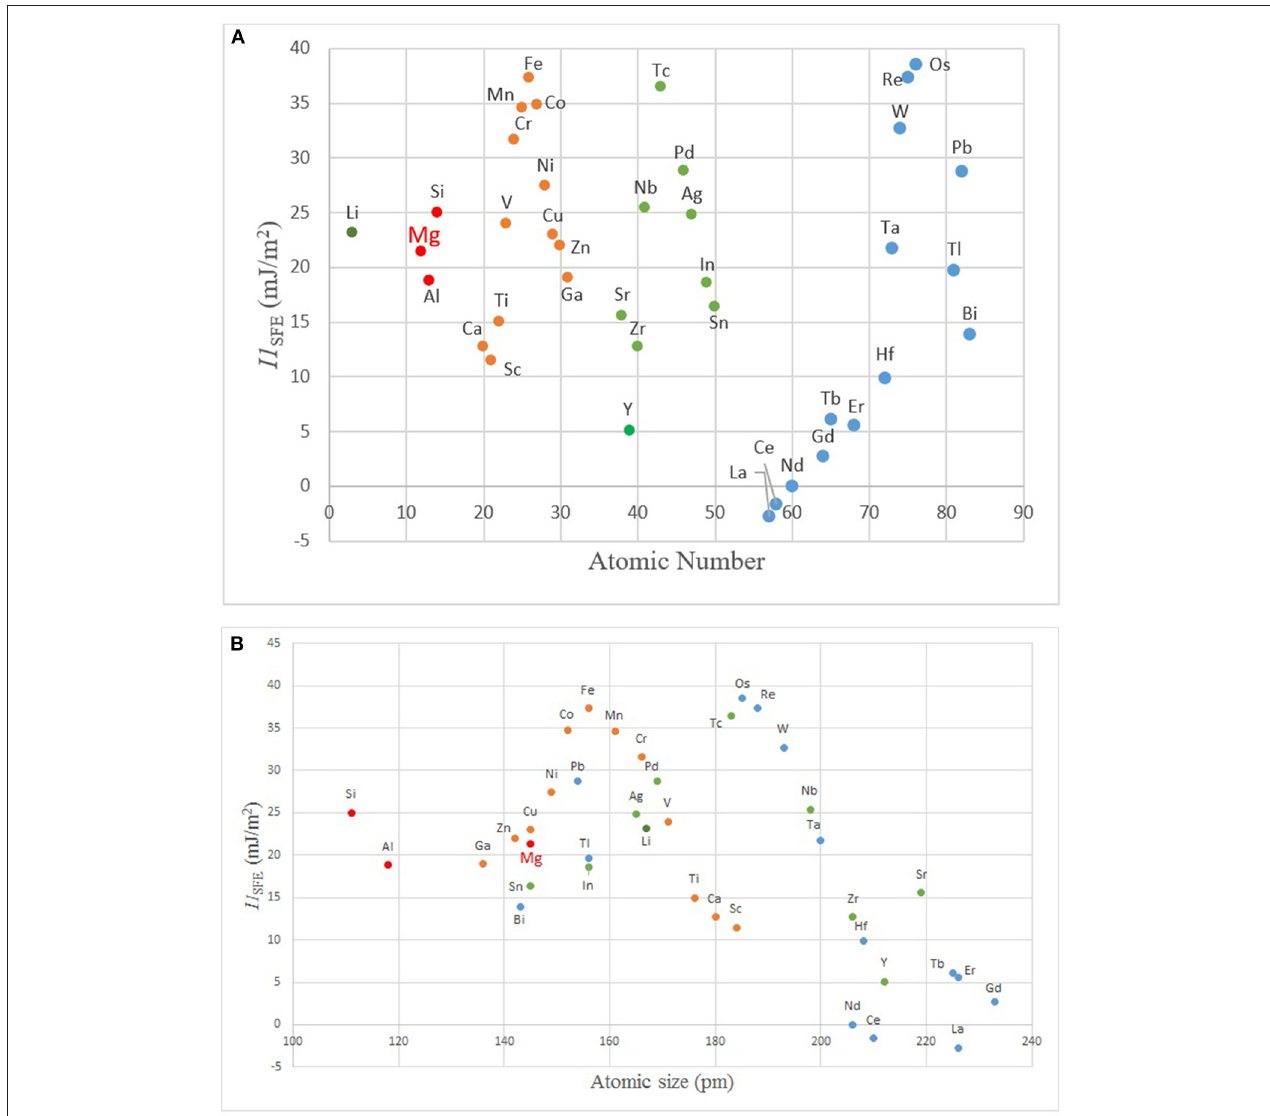
FIGURE 6 | The plots of I1 SFE vs. (A) atomic number, and (B) size showing modulations (SFE values from Wang T. et al., 2014; Dong et al.,